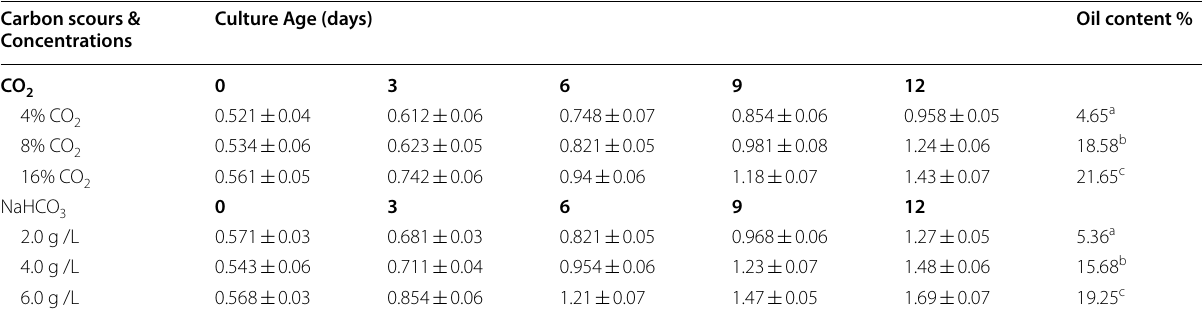
Table 1 Impact of carbon scours and concentrations on Pseudochlorella pringsheimii growth ( dry weight g/L) and oil contents (%)